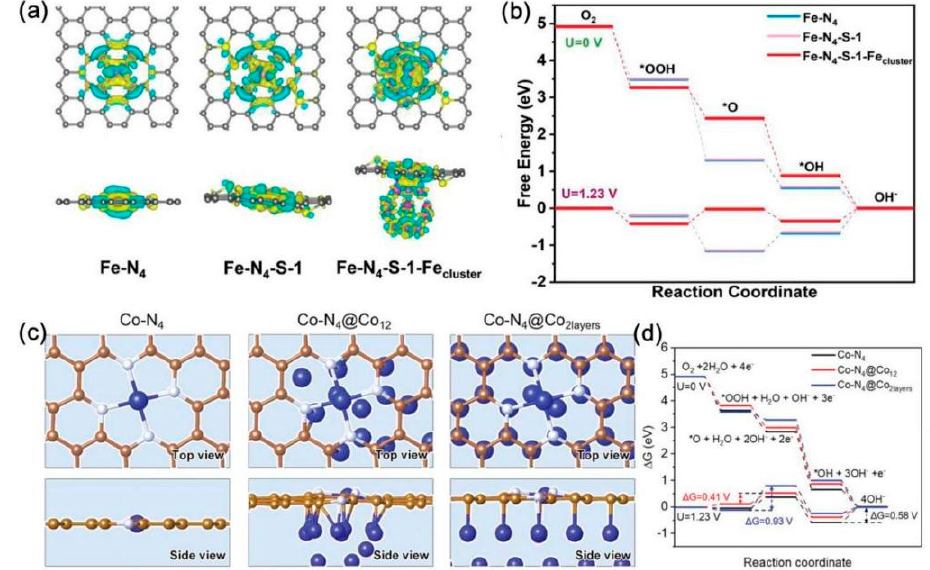
Figure 6. DFT calculations of ( a ) charge densities (yellow: electron accumulation, cyan: electron depletion) ( b ) free energis at U = 0 V, and 1.23 V for Fe-N 4 , Fe-N 4 -S-1, and F-N 4 -S-1-Fe cluster . Repro- duced from Ref. [73], John Wiley & Sons Ltd.: 2022 ( c ) Top views and side views of the optimized atomic structures of Co-N 4 , Co-N 4 @Co 12 , and Co-N 4 @Co 2layers ; ( d ) ORR free energy for Co-N 4 (black line), Co-N 4 @Co 12 (red line), and Co-N 4 @Co 2layers (blue line) at U = 0 V, and 1.23 V along 4-electrons pathway. Reproduced from Ref. [75], John Wiley & Sons Ltd.: 2021